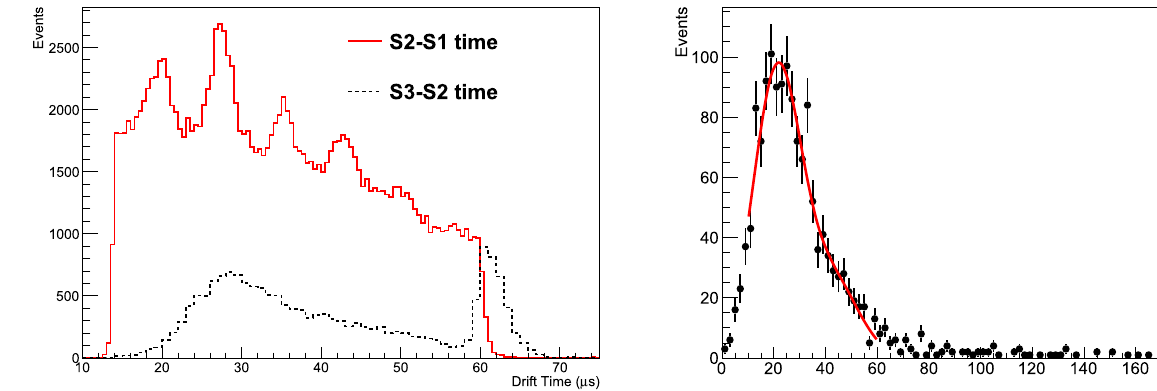
Fig. 19 Left: Distribution of the drift time between S1 and S2 signals (red curve) and between S2 and S3 signals (black curve) for a set of 241 Am measurements taken in double-phase mode at E